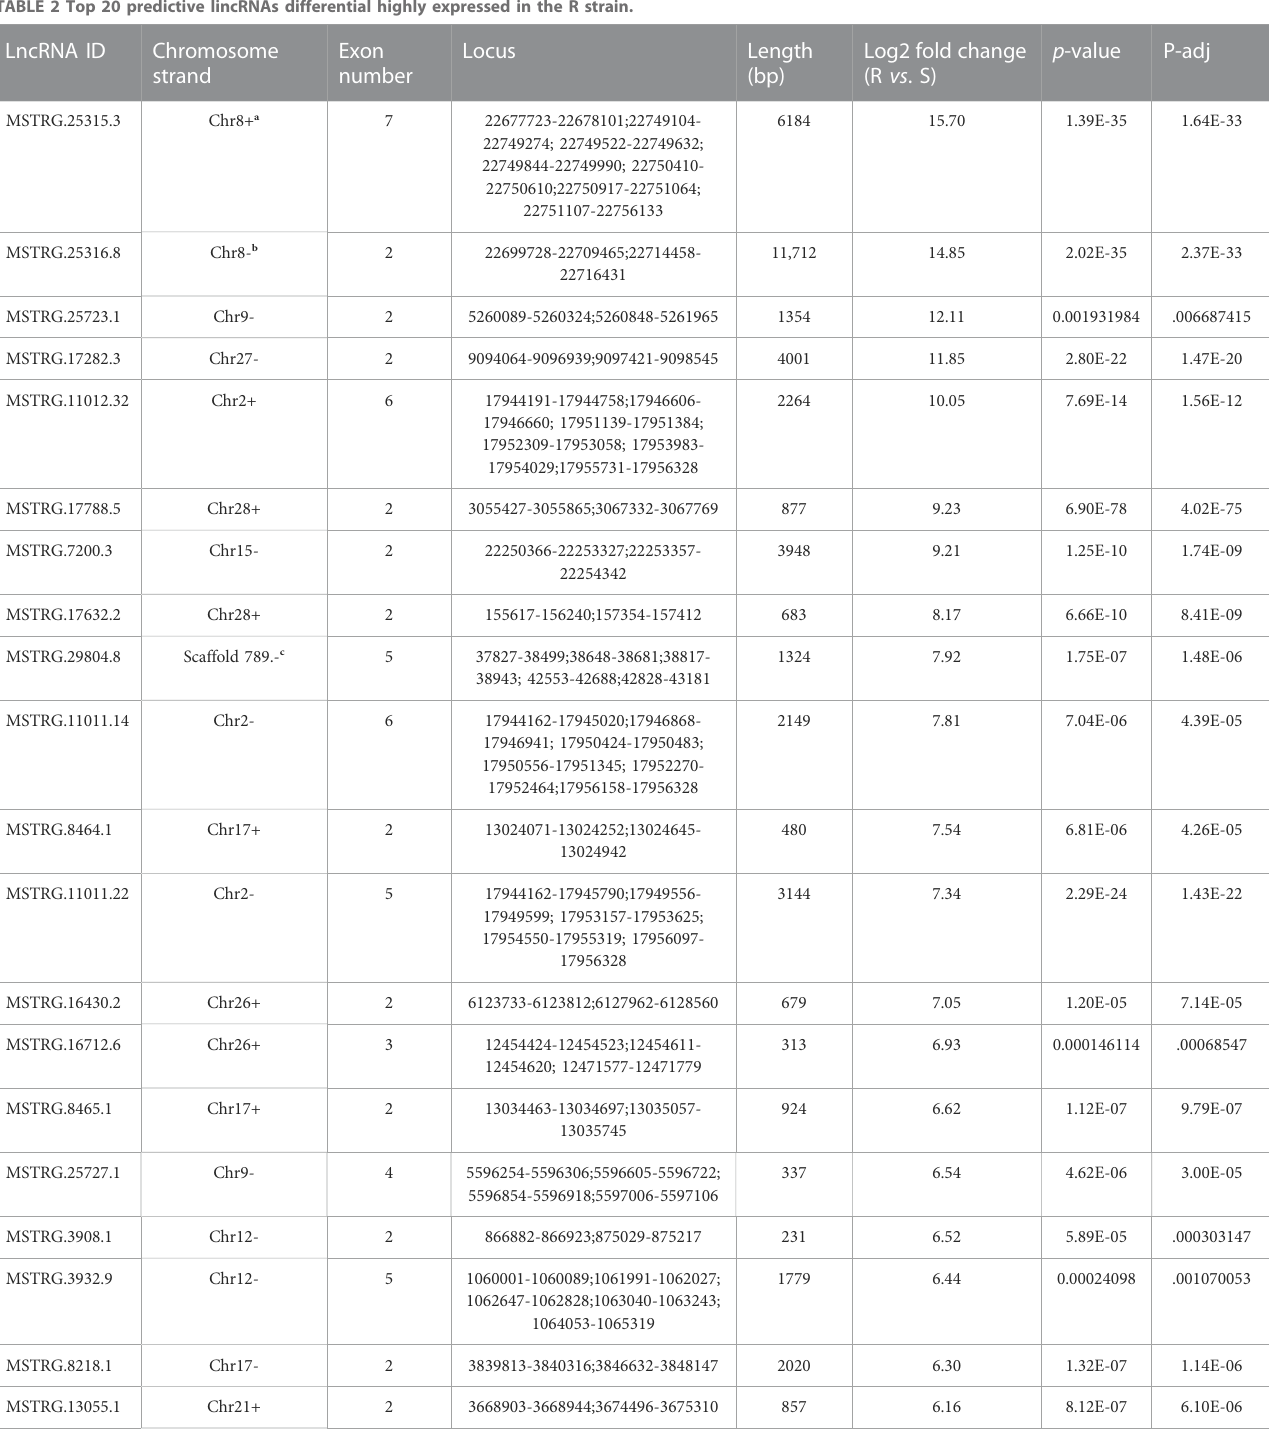
TABLE 2 Top 20 predictive lincRNAs differential highly expressed in the R